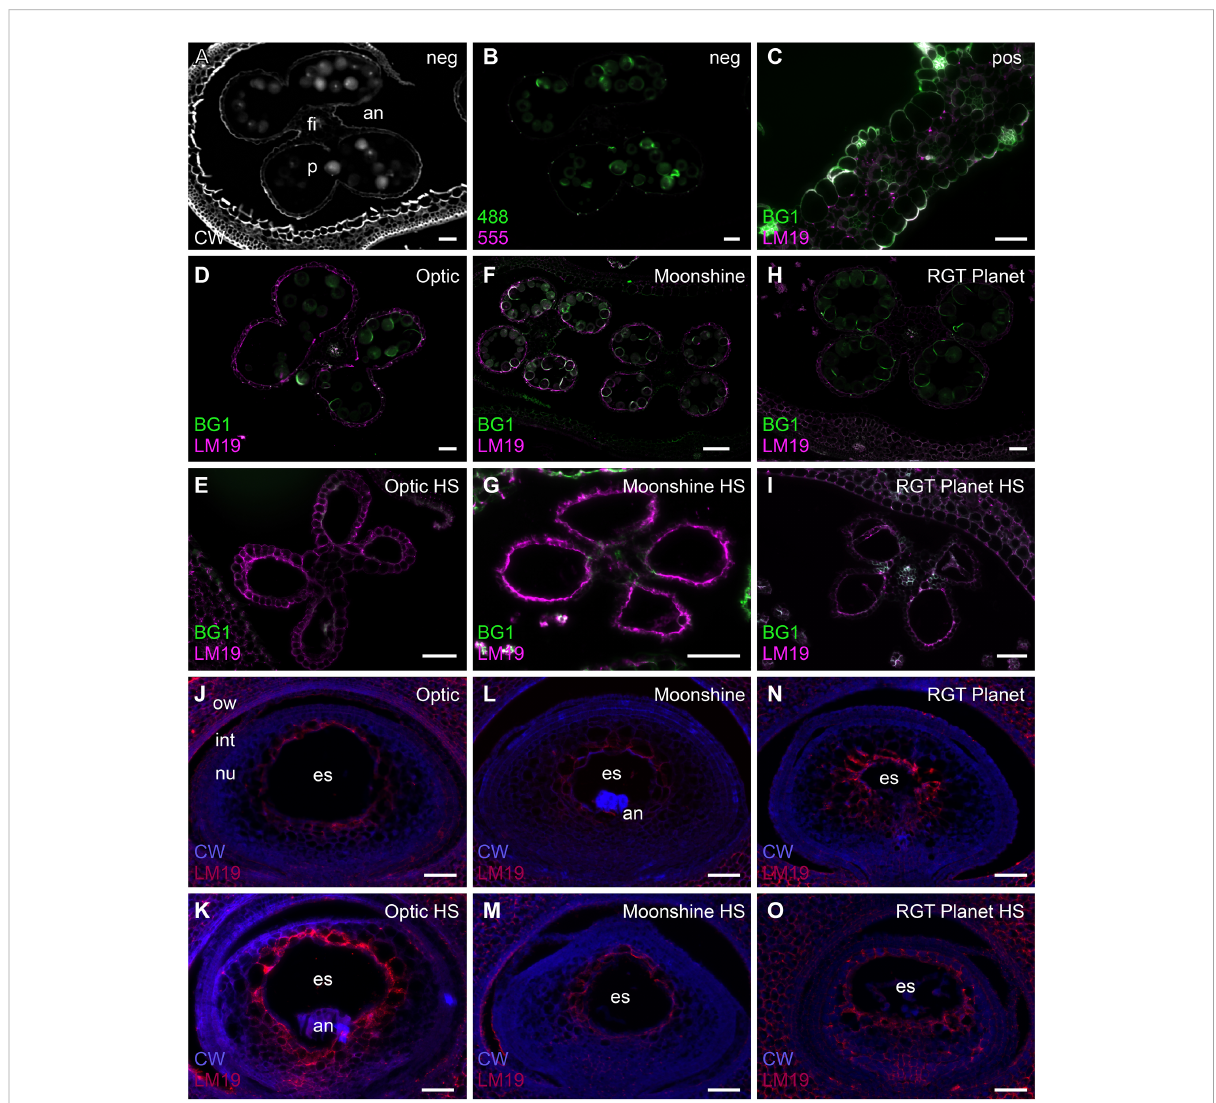
FIGURE 3 Immunolabelling of cell wall components in anthers and ovules in Optic, Moonshine and Planet. (A) Calco fl uor white staining (CW, white colour) of a control anther (an). The fi lament ( fi ) and pollen (p) are indicated. (B) The same anther shown in A, showing auto fl uorescence (green) in the Alexa fl uor-488 channel. (C) A barley leaf sample showing positive labelling of (1,3;1,4)- b -glucan (BG1, green) and de-esteri fi ed pectin (LM19, magenta). (D – O) Comparison of control and heat stressed anthers and ovules in barley fl orets of the three varieties. Merged images of the antibody labelling patterns are shown. (D) Optic control anther. (E) Optic heat-stressed anther. (F) Moonshine control anther. (G) Moonshine heat-stressed anther. (H) Planet control anther. (I) Planet heat-stressed anther. (J) Optic control ovule. The ovary wall (ow), integuments (int), nucellus (nu) and embryo sac (es) are indicated. (K) Optic heat-stressed ovule. In this ovule the antipodals (an) are also evident. (L) Moonshine control ovule. (M) Moonshine heat-stressed ovule. (N) Planet control ovule. (O) Planet heat-stressed ovule. Bar = 50µm in all images. Images are representatives from at least 3 different fl orets per variety/heat stress